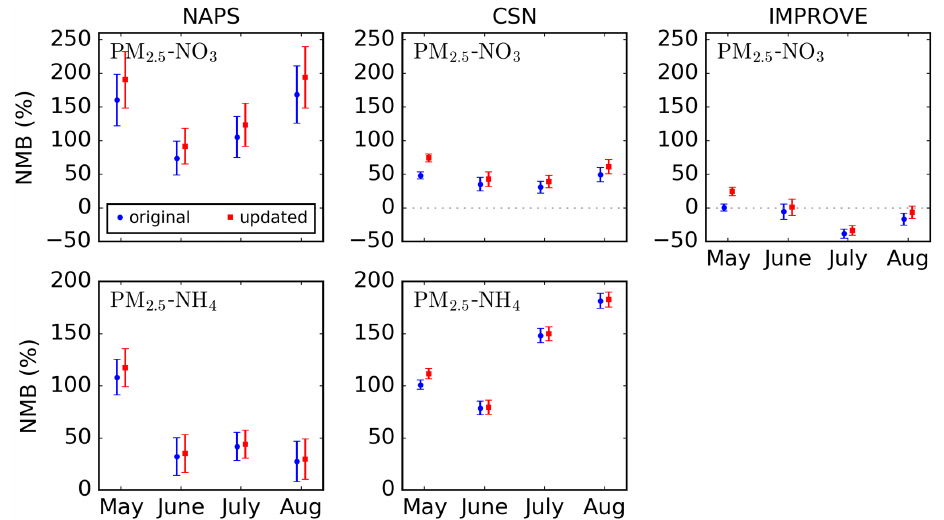
Figure 13. Monthly normalized mean biases between GEM-MACH PM 2 . 5 -NO 3 and PM 2 . 5 -NH 4 surface concentration fields and observa- tions from the NAPS, CSN, and IMPROVE networks for May to August 2016. In the legend, “original” and “updated” indicate the ammonia emissions used in GEM-MACH. Error bars correspond to the standard error.